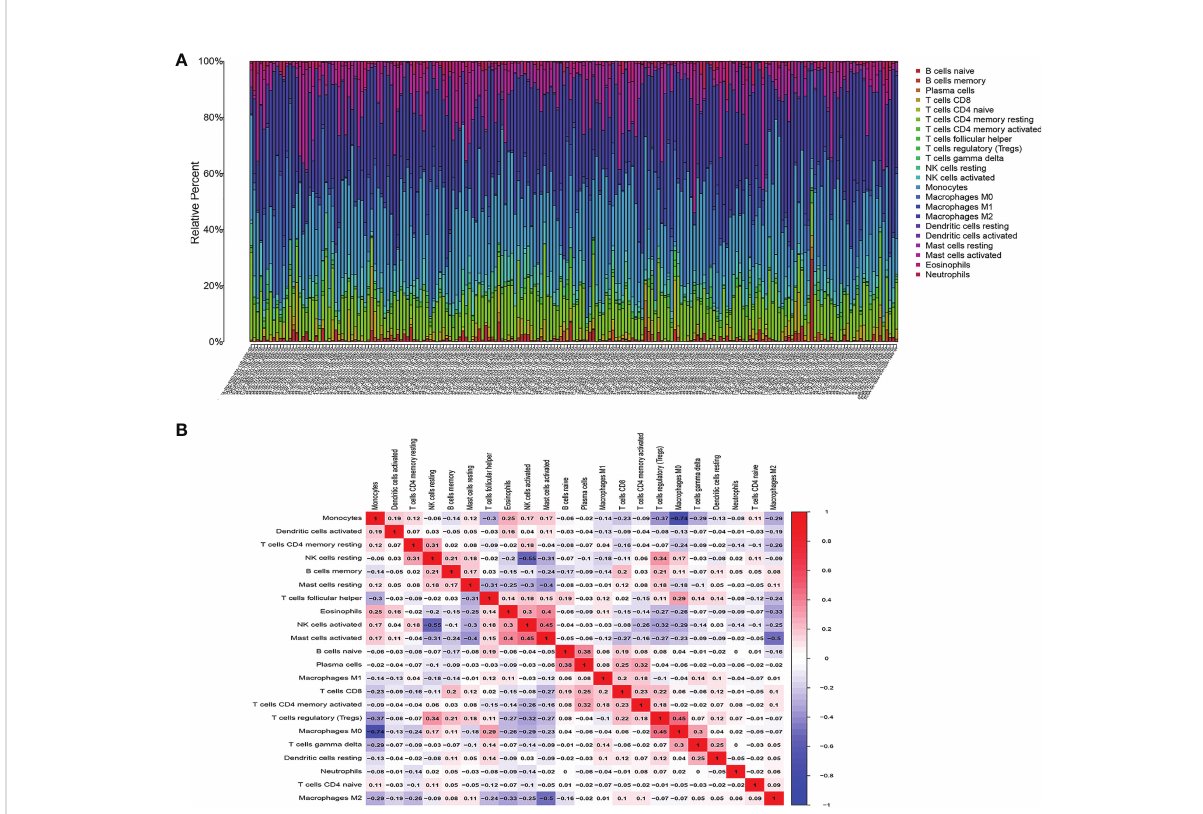
FIGURE 8 Composition of in fi ltrated immune cells between paired tumor and adjacent normal tissues in the TCGA cohort with CIBERSORT p < 0.05 for all eligible samples, 22 immune cells in TCGA cohort were fi ltered for analyzing, (A) Fractions of immune cells in 698 tumor and 5 normal samples in TCGA. (B) Correlation matrix of all 22 tumor-in fi ltrating immune cells proportions. Horizontal and vertical axes both represent tumor- in fi ltrating immune cells. tumor-in fi ltrating immune cells with higher, lower, and same correlation levels are shown in red, blue, and white,